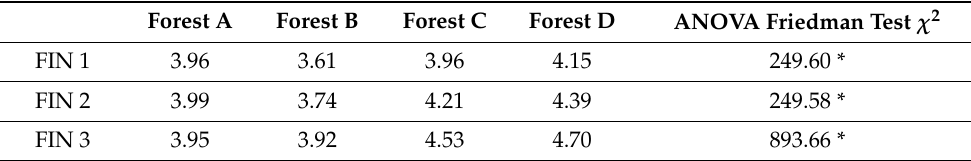
Table 5. Correlation between forest development level and WTP for